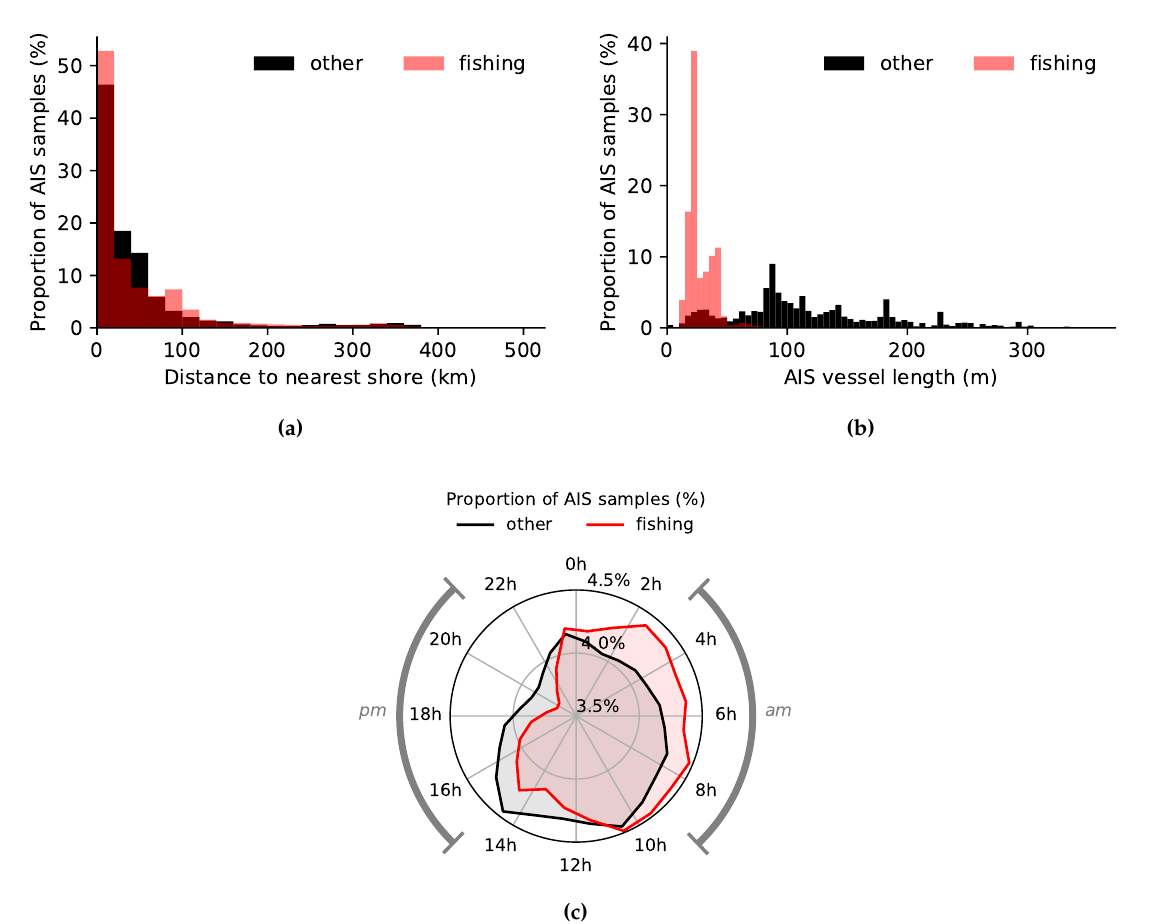
Figure 6. Distribution of ( a ) the distance to nearest shore, ( b ) the length, and ( c ) the time of the day for all the fishing (red) and non-fishing (other; black) samples of the AIS data. For ( c ), only the samples within the am and pm segments are used for training. The total number of fishing and non-fishing samples are 137,749 and 953,607,